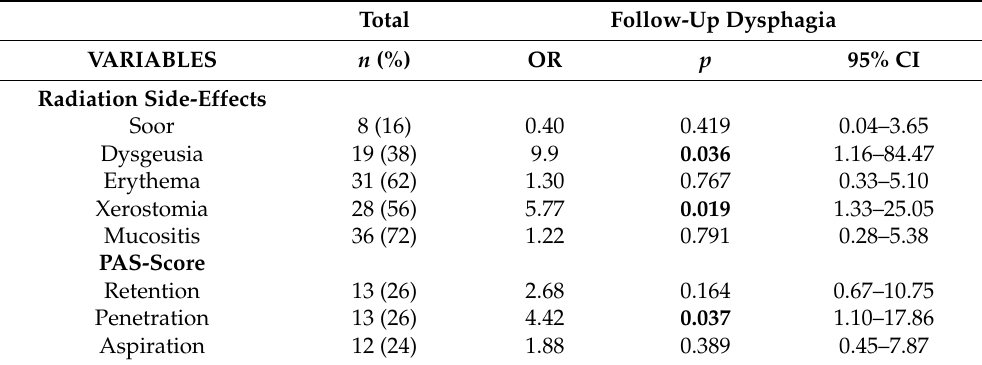
Table 4. Impact of radiation-associated side-effects and PAS score on follow-up dysphagia.